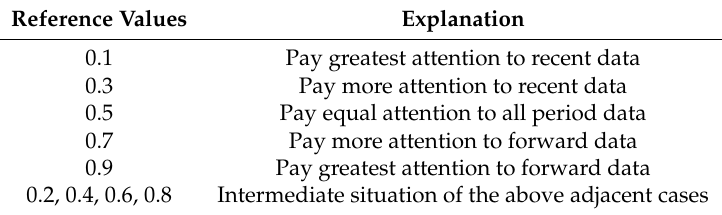
Table 2. Reference values of the time degree ( λ